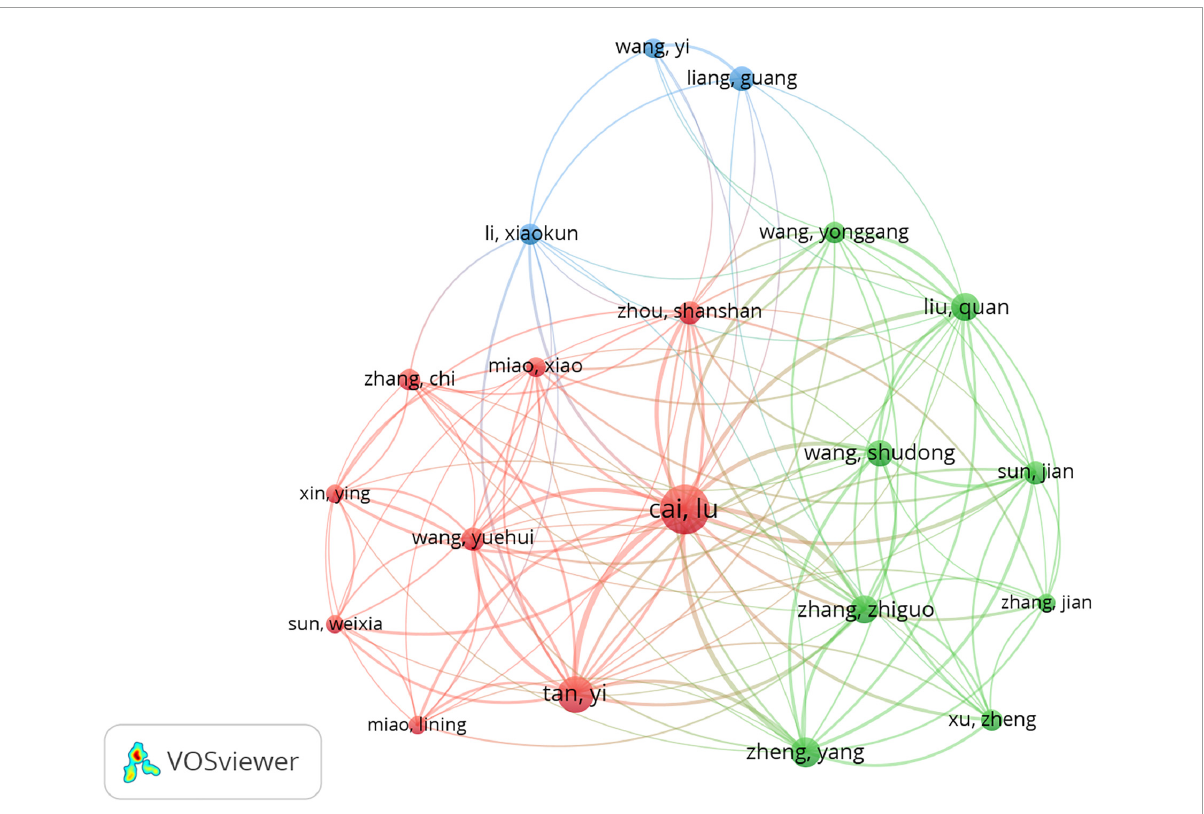
FIGURE4 Network map of co-authorship analysis of authors in inflammation related to diabetic cardiomyopathy (DCM) research. The analysis method was Linlog/modularity in VOSviewer, the weight was an occurrence, and scores were the average published year.